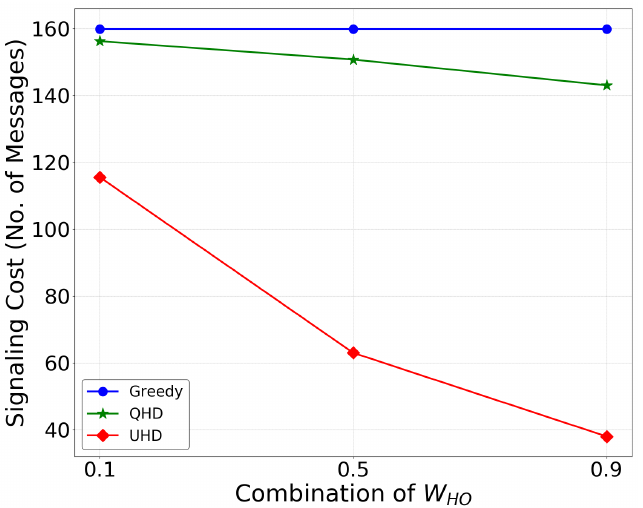
Figure 9. Control signaling cost comparison among UHD, QHD, and greedy methods with 0.1, 0.5, and 0.9 W HO